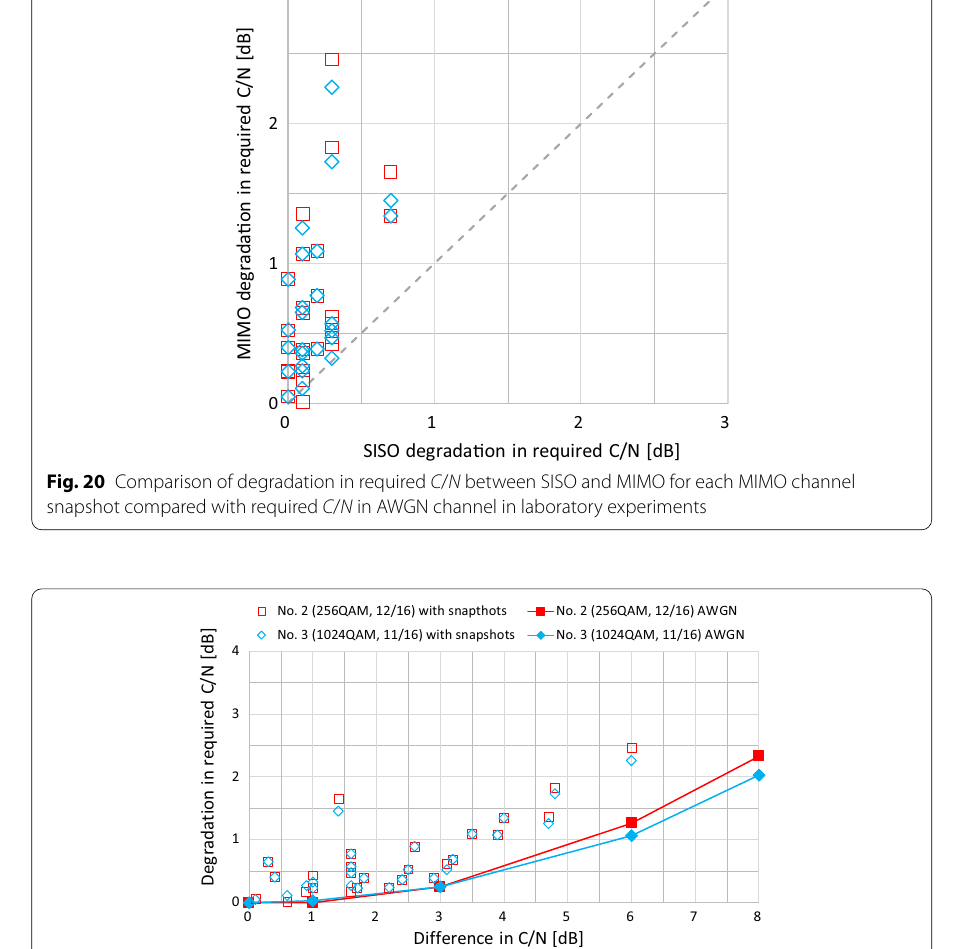
Fig. 21 Degradation in required C / N from viewpoint of difference in C / N between horizontal and vertical polarization for each MIMO channel snapshot compared with required C / N in AWGN channel in laboratory